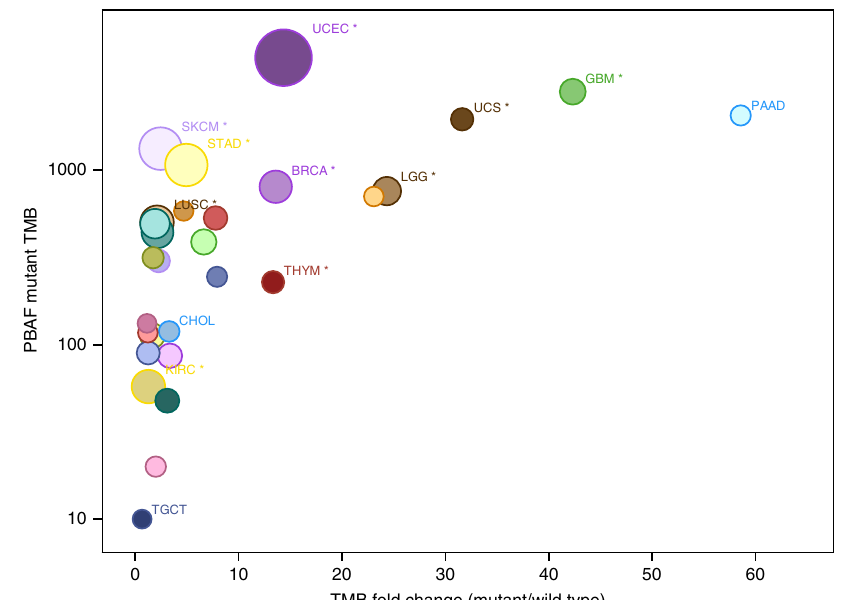
Fig. 2 Mutation burden in PBAF complex altered tumors. Tumor mutation burden (TMB) of PBAF complex mutated tumors in the TCGA plotted against TMB ratio of mutated tumors vs. wild